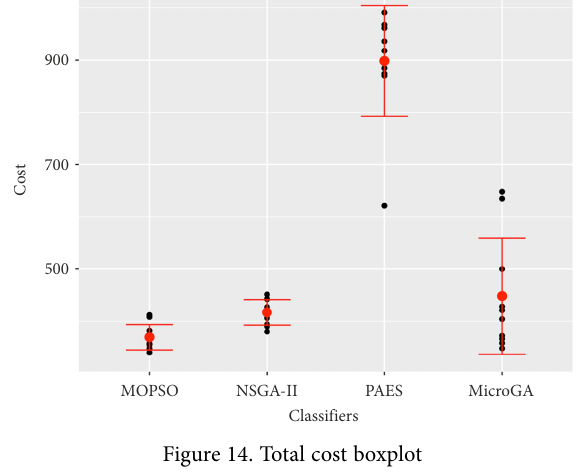
Figure 14. Total cost boxplot